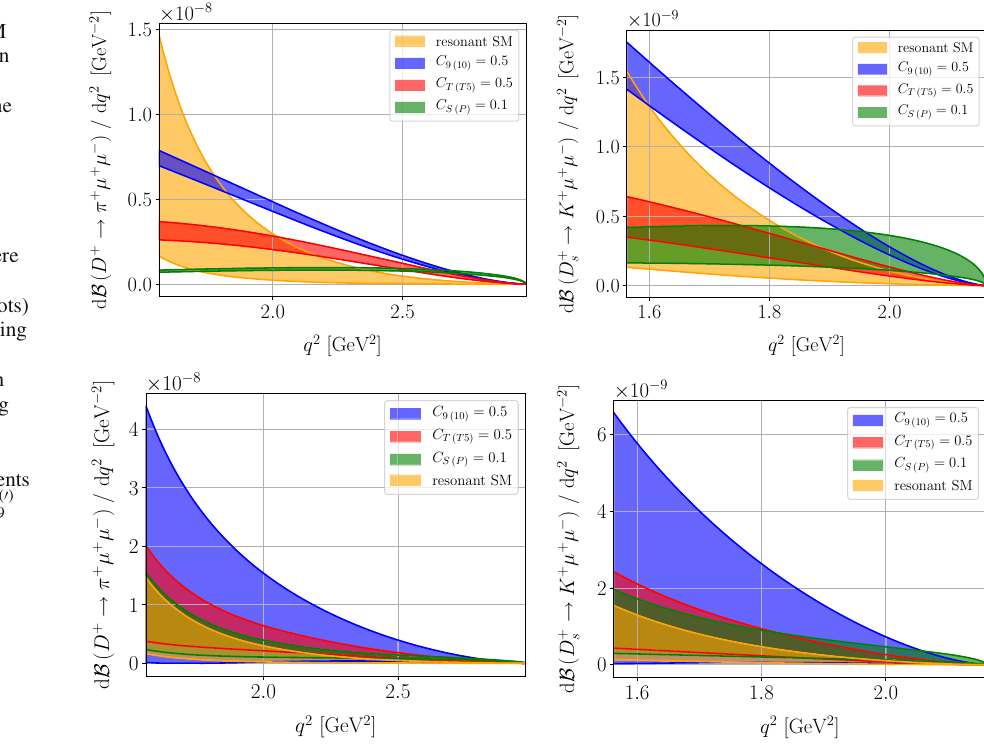
(cid:14) q 2 ≥ 1 . 25 GeV) in the SM and in the NP benchmark scenarios as in Fig. 3. In the = 0 . 5 C = 0 . 1 C = 0 . 5 C = ± C = 0 . S ( P ) T ( T 5 ) 9 10 9 ( 10 )